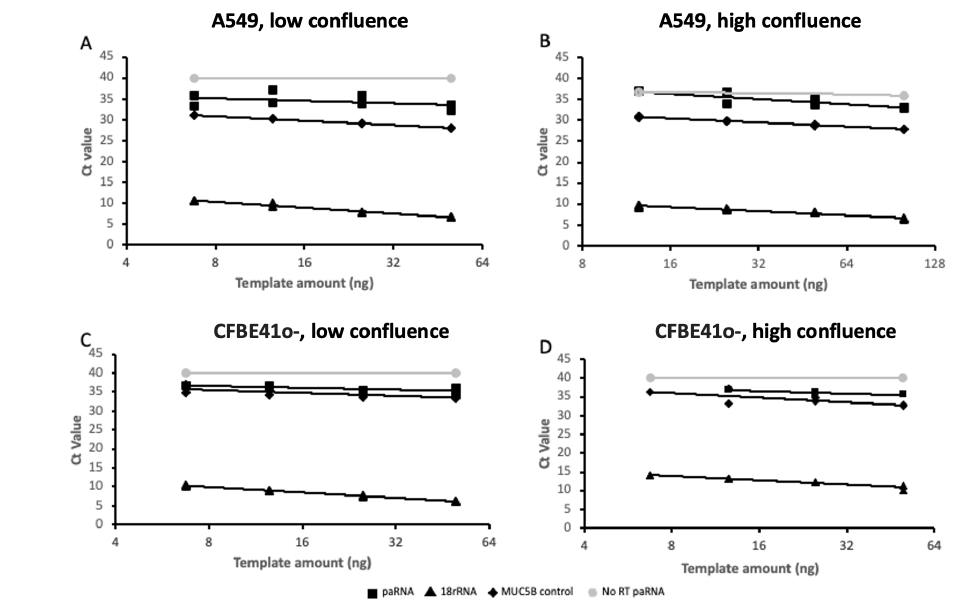
Figure 4. AC061979.1 expression validation in cell culture. Two-fold serial dilutions of A549 ( A , B ) and CFBE41o- ( C , D ) RNA extracts obtained from low- ( < 30%; ( A , C )) and high- ( > 70%; ( B , D )) confluence cells were analysed by probe hydrolysis RT-qPCR for 18S rRNA (triangle), MUC5B (diamond) and AC061979.1 pancRNA (square) expression across two-fold serial dilutions, with a no RT of AC061979.1 reaction set included as a negative control (grey circles). Data are expressed in log2-linear scale and are representative of three independent biological experiments and dual technical replicate Ct’s points